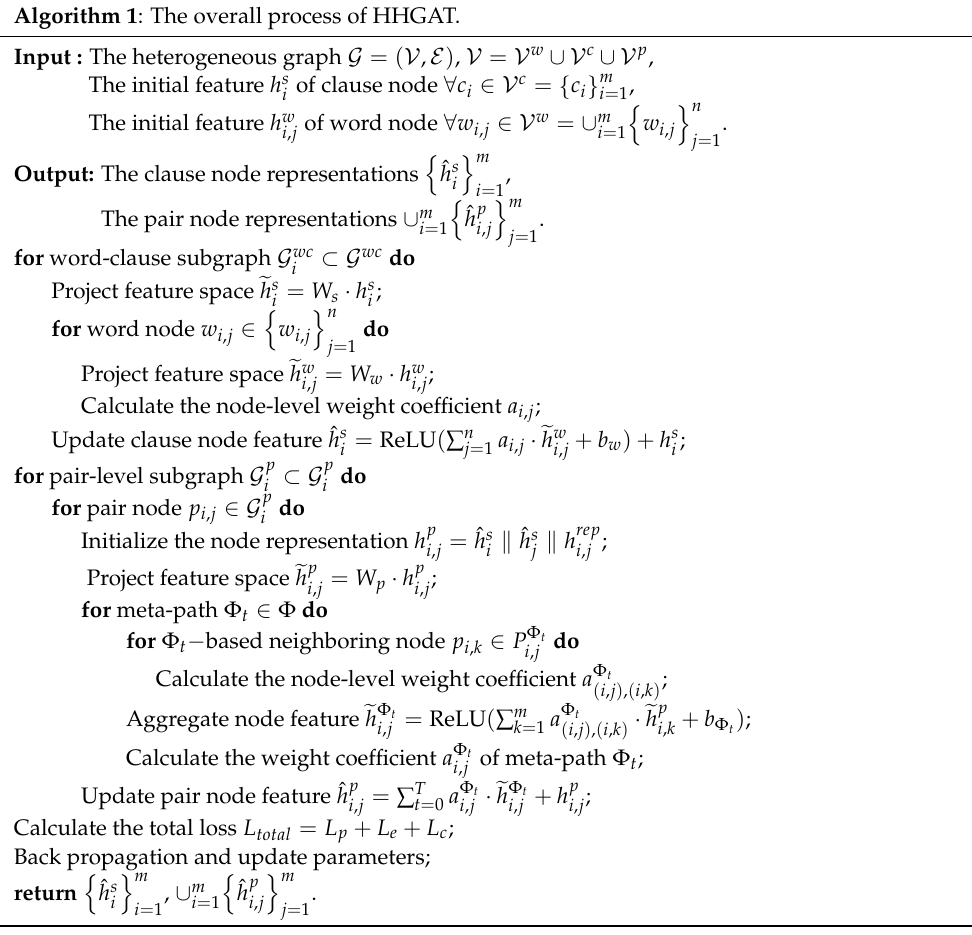
Algorithm 1 : The overall process of